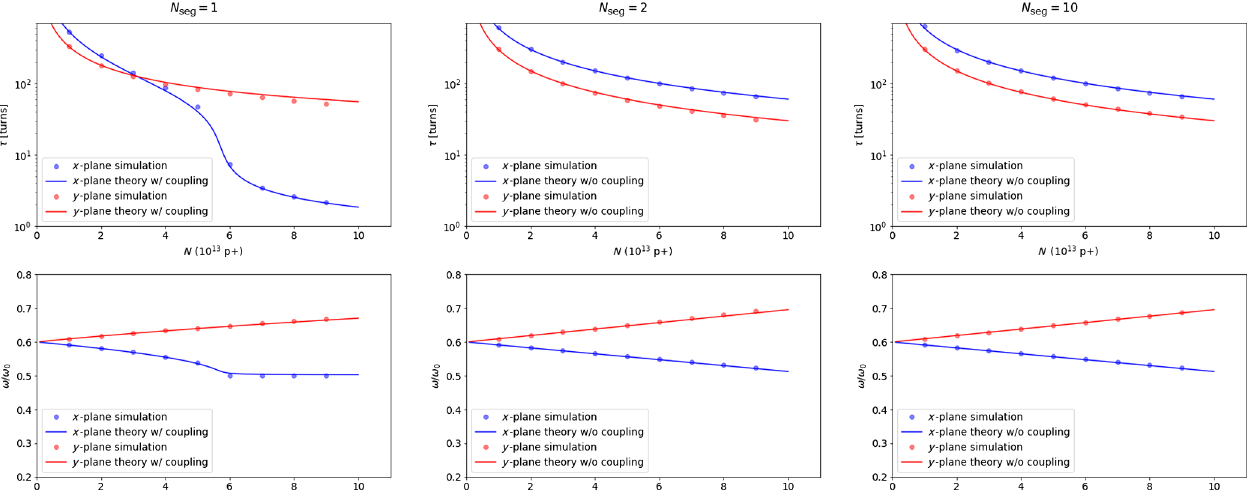
1 ) and without coupling (for seg ¼